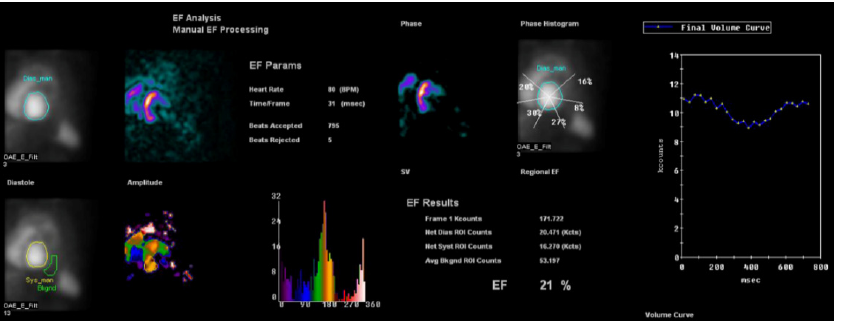
Figure 6. Multigated acquisition (MUGA) scan demonstrating reduced ejection fraction (EF = 21%) in